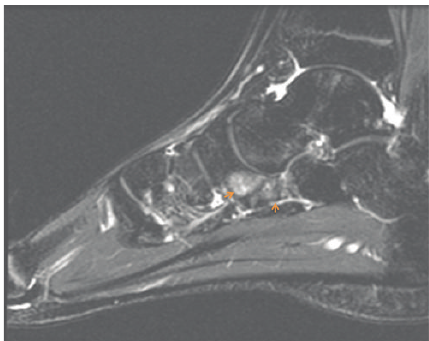
Figure 4: Sagittal STIR unenhanced MR image of the right foot in a 17-year-old male with cuboid-navicular coalition reveals abnormal articulation between the cuboid and navicular as well as marrow edema along both sides of the coalition